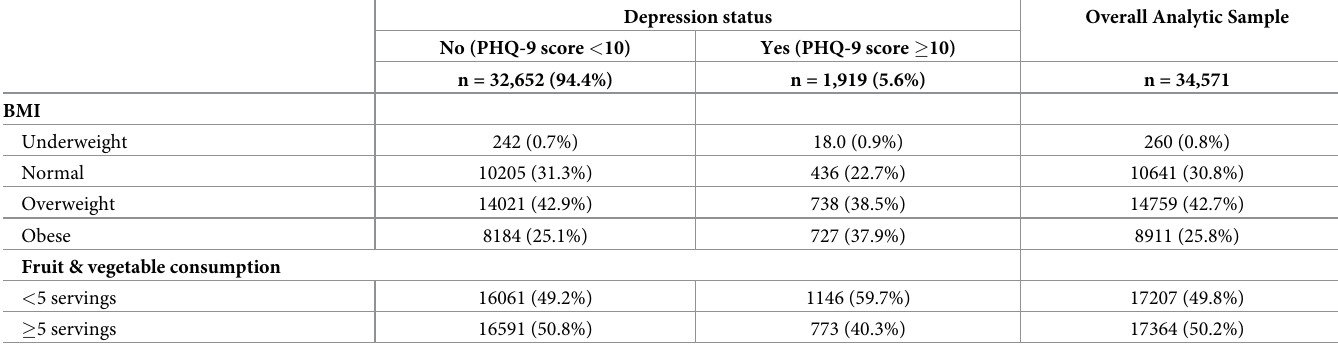
Mental health characteristics of the analytic sample are presented in Table 3. Depression defined by antidepressant use was observed in 9.2% of the analytic sample, and depression defined by PHQ-9 scores was observed in 5.6% of the sample. Self-reported lifetime depression diagnosis by a physician was observed for a higher proportion of the sample (21.5%). Anxiety defined by GAD-7 scores occurred in 4.6% of the sample, and comorbid anxiety and depres- sion was observed in 2.7%.